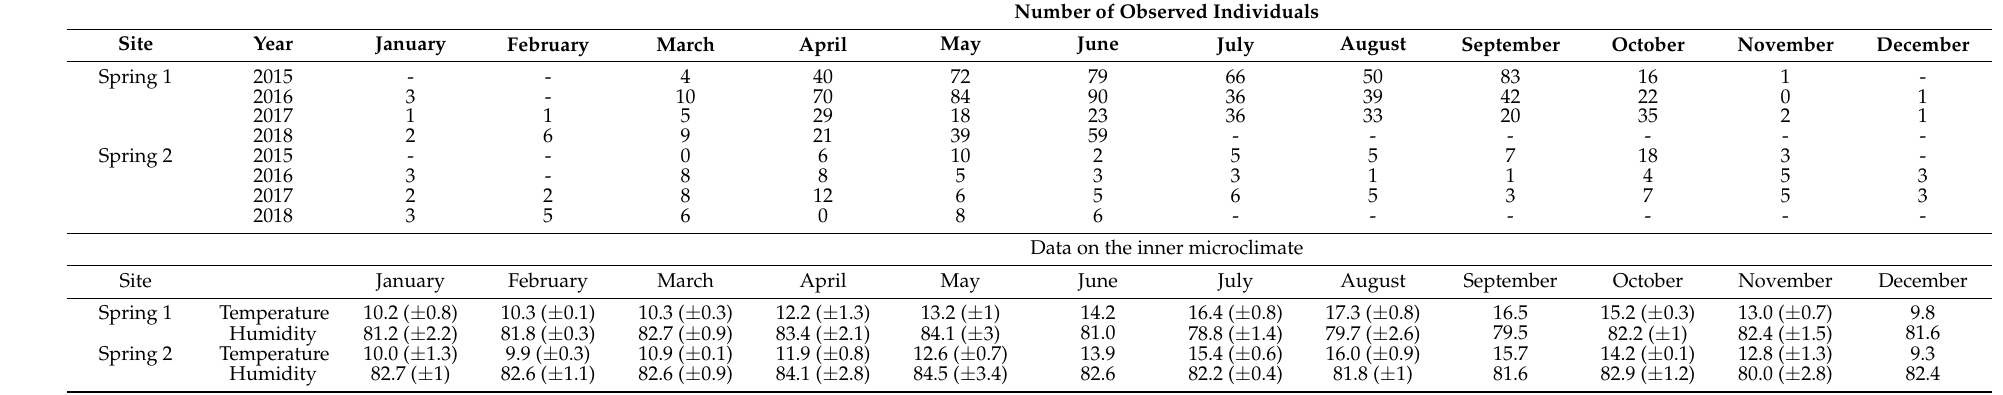
Table 1. Monthly data from the long-term monitoring of Speleomantes sarrabusensis . In the upper part of the table, we show the monthly count performed within the two artificial springs coded following Lunghi, et al. [27]. The symbol (-) indicates that the survey has not been performed. In the lower part, we show the average monthly microclimatic conditions recorded inside the two artificial springs during the monitoring period. For each month, we show the average ( ± SD) temperature ( ◦ C) and relative humidity (%) recorded during the period 2015–2018. When the standard deviation is not shown, it means that the relative microclimatic variable has been recorded only